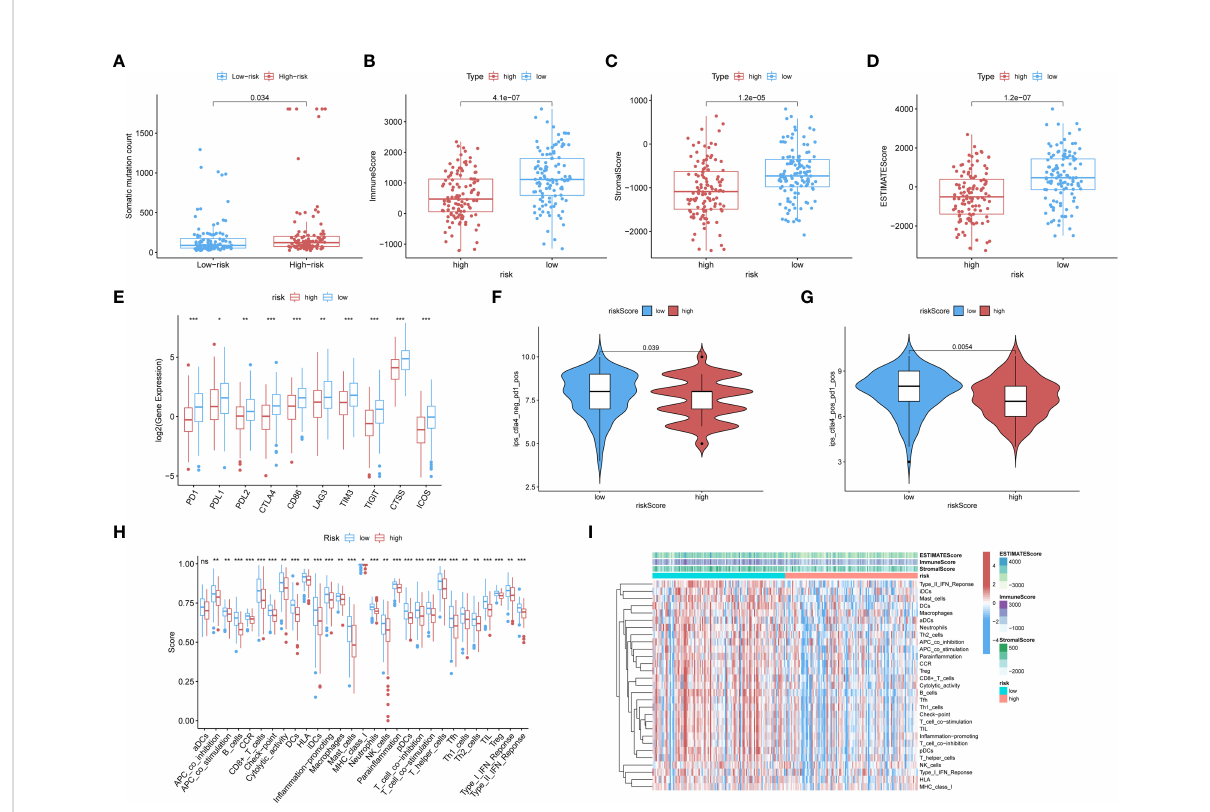
FIGURE 3 (A) The boxplots showed the results of the Wilcoxon test for some characteristic distribution differences between discrepantly-risked clusters, including TMB. The low-risk population takes fewer somatic mutation counts, with a p-value = 0.034. (B) Immune Score with p-value = 4.1 ∗ e − 07 , (C) Stromal Score with p-value = 1.2 ∗ e − 05 , (D) ESTIMATE Score with p-value = 1.2 ∗ e − 07 and all of them appeared to be higher in low- risk cohort. (E) ICPs differently distributed were also depicted in the boxplot, including PD1, PDL1, PD2, CTLA4, CD86, LAG3, TIM3, TIGIT,